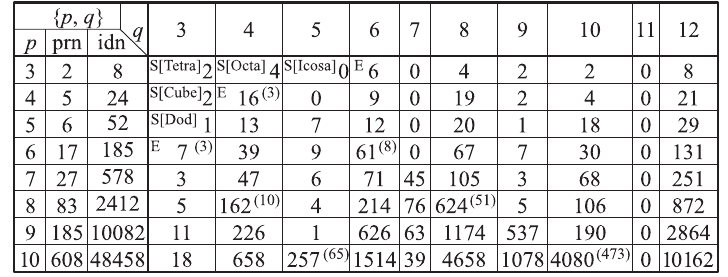
Table 1. Prn: the number of different edge pairings; Idn: the number of different edge